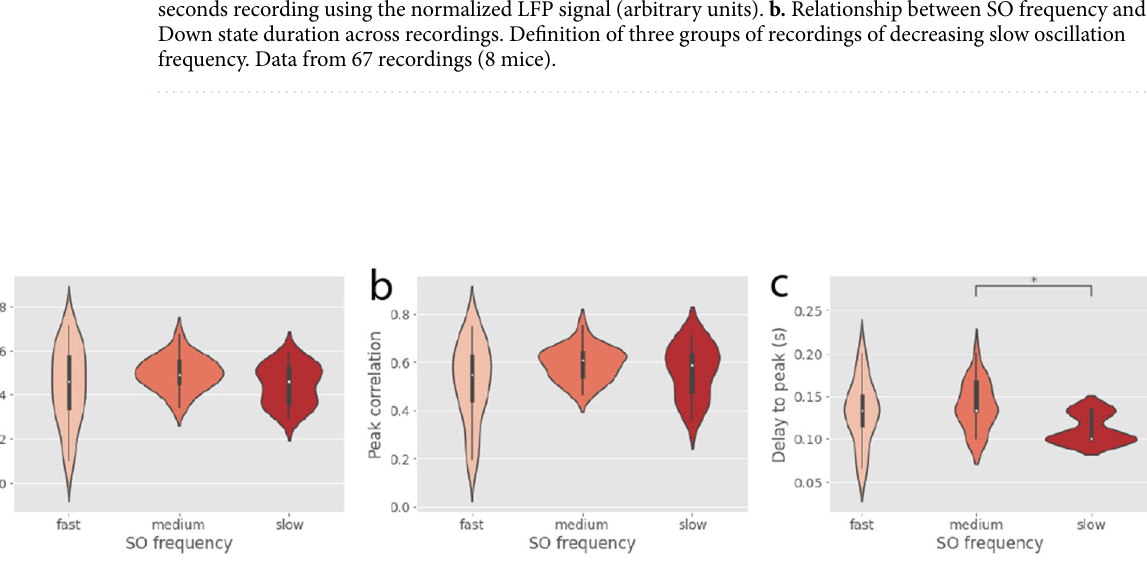
Figure 4. Correlation between LFP and calcium signals. LFP-FOV Pearson’s correlation ( a ), peak cross- correlation ( b ) and delay to peak ( c ) as a function of slow oscillation frequency (n=67 recordings, 8